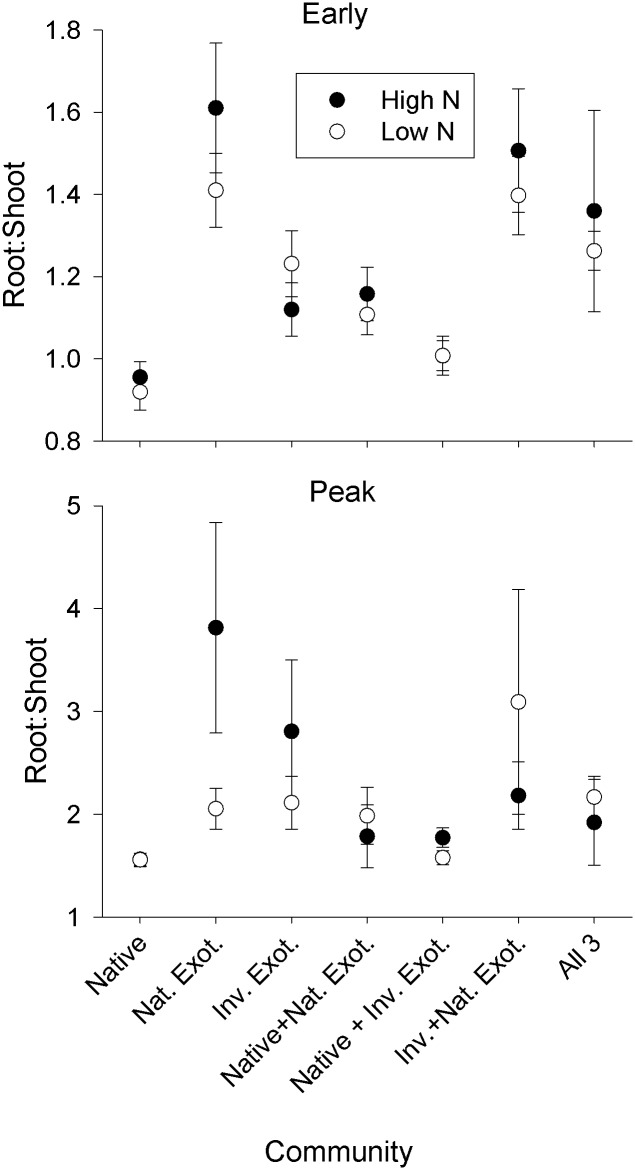
Root:shoot (± SE) at the community level for each community type under high versus low N fertilization during early growth and peak biomass stages.High N communities are represented by black symbols, low N by white symbols. Note difference in y-axis scales.